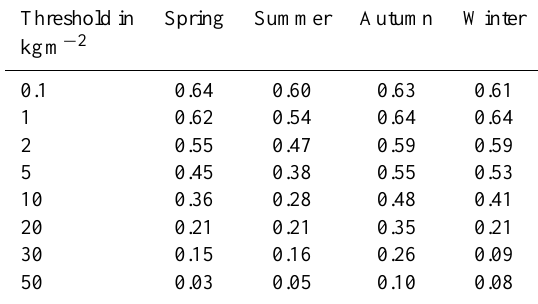
Table 5. Values of the Pierce Skill Score for operational COSMO forecasts of precipitation at MeteoSwiss using different thresholds. The four seasons are evaluated separately.